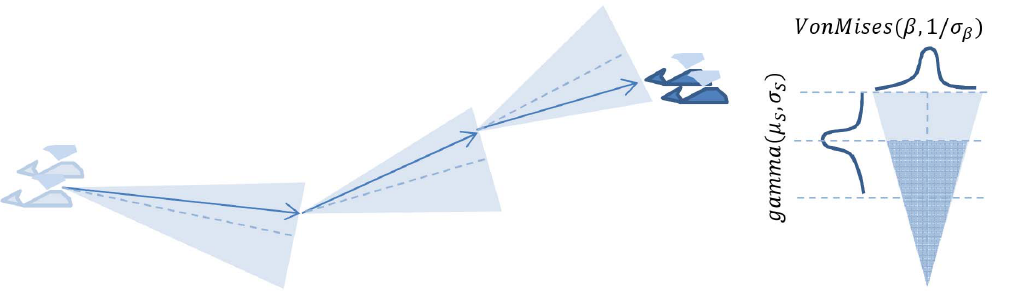
Figure 1. Representation of the correlated random walk used to simulate whale group movement. At each time step, a random variation is added to the cumulative direction (and the distance travelled), causing heading to change smoothly through time.